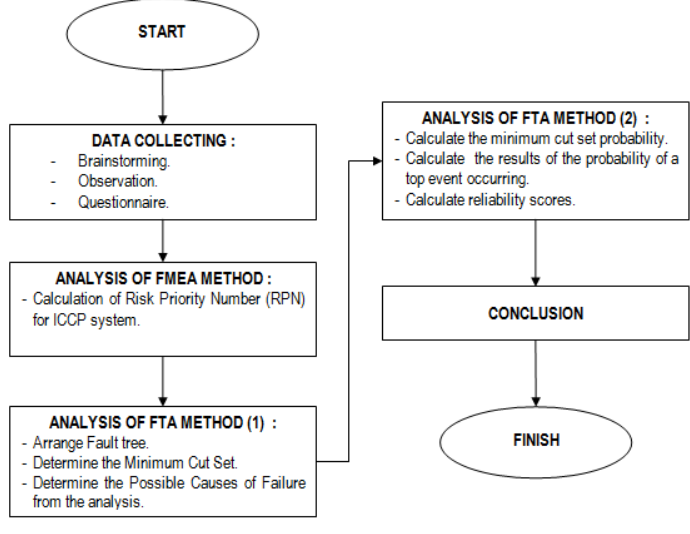
Figure 3. Flowchart of Research Paper